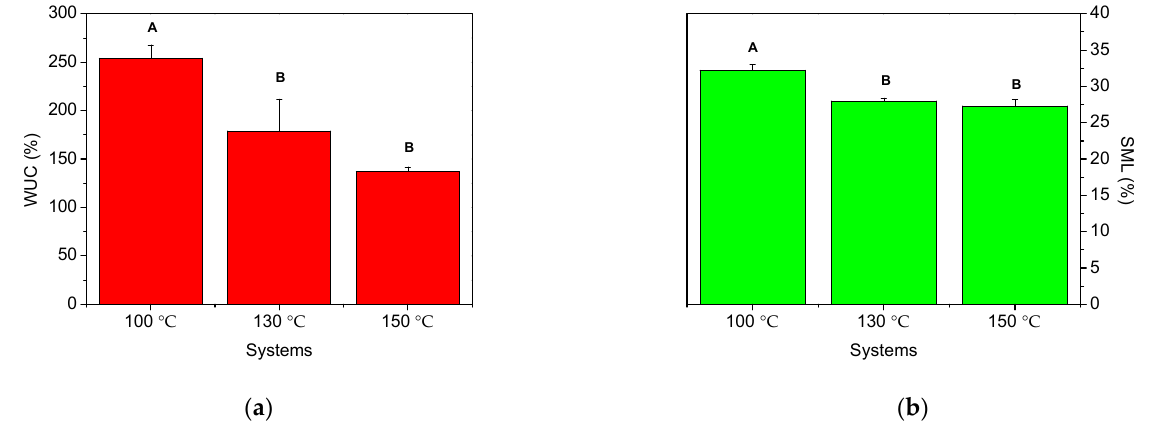
Figure 4. ( a ) Water uptake capacity (WUC) and ( b ) Soluble Matter Loss (SML) for the bioplastics obtained for different mould temperatures (100, 130 and 150 ° C). Different letters above each bar indicate significant differences ( p < 0.05).